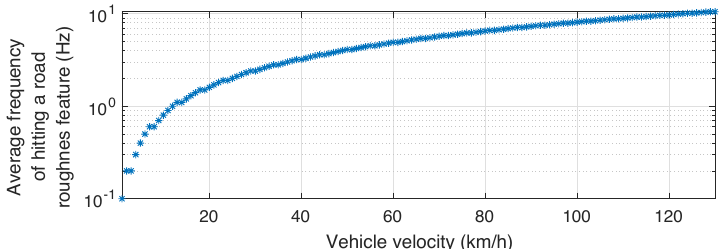
Figure 9. Average frequency of the vehicle hitting a roughness feature in the road condition data of an Australian road [31], estimated for varying vehicle velocities.